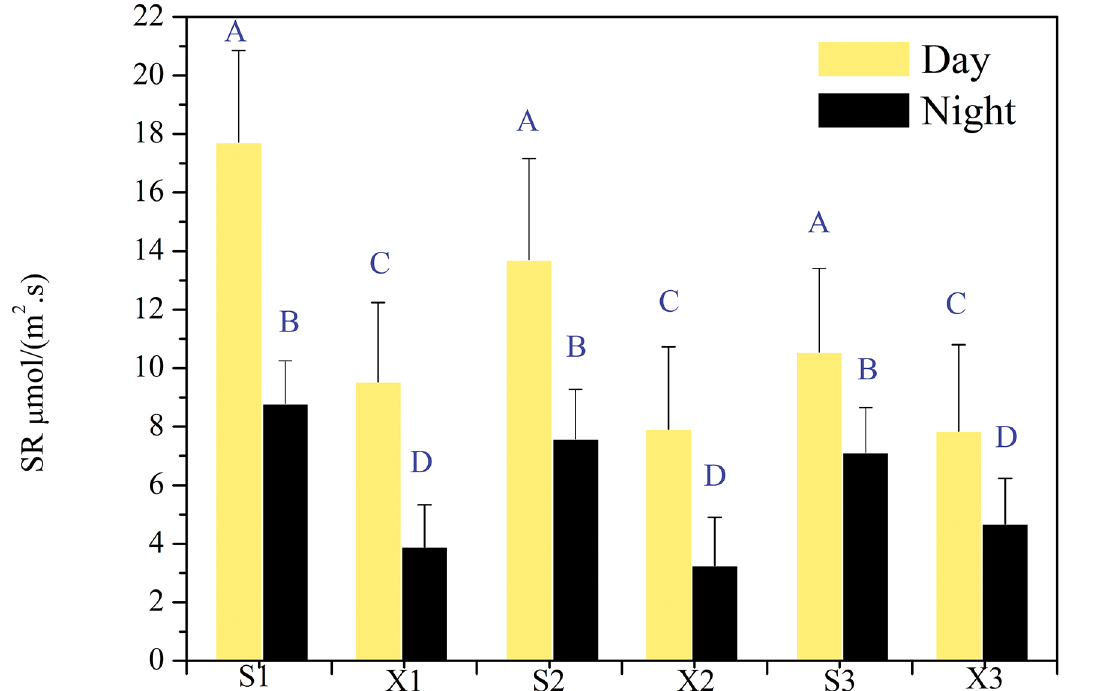
Fig 2. Seasonal average sites value of Soil respiration (SR) in Shang shoal and Xia shoal. S1~S3: three samples in Shang shoal, X1~X2: three samples in Xia shoal. Different capital letters (A, B, C, D) above the error bar represent significant difference between two areas at the 0.01 level.